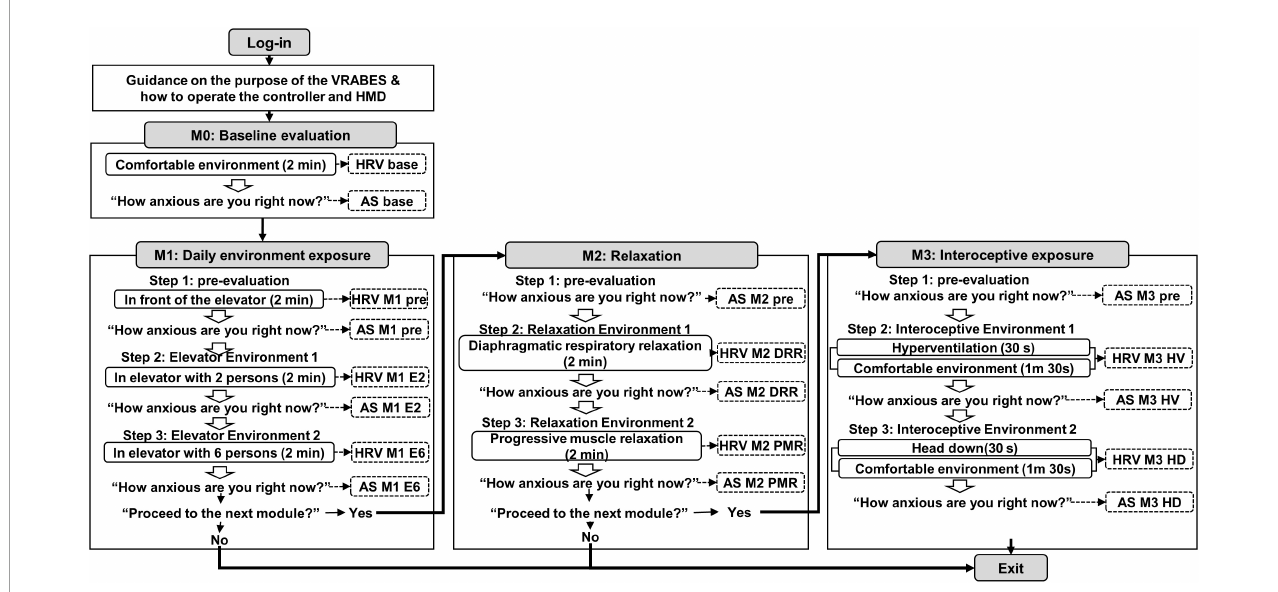
FIGURE1 Configuration diagram of the virtual reality-based assessment in panic disorder (VRA-PD). A box with rounded corners inside an angled rectangle representing a module describes the virtual environment. An empty arrow means a process that checks whether to proceed after the virtual environment. Items marked with dotted lines indicate recorded variables. M, module; DRR, diaphragmatic respiratory relaxation; PMR, progressive muscle relaxation; HV, hyperventilation; HD, head